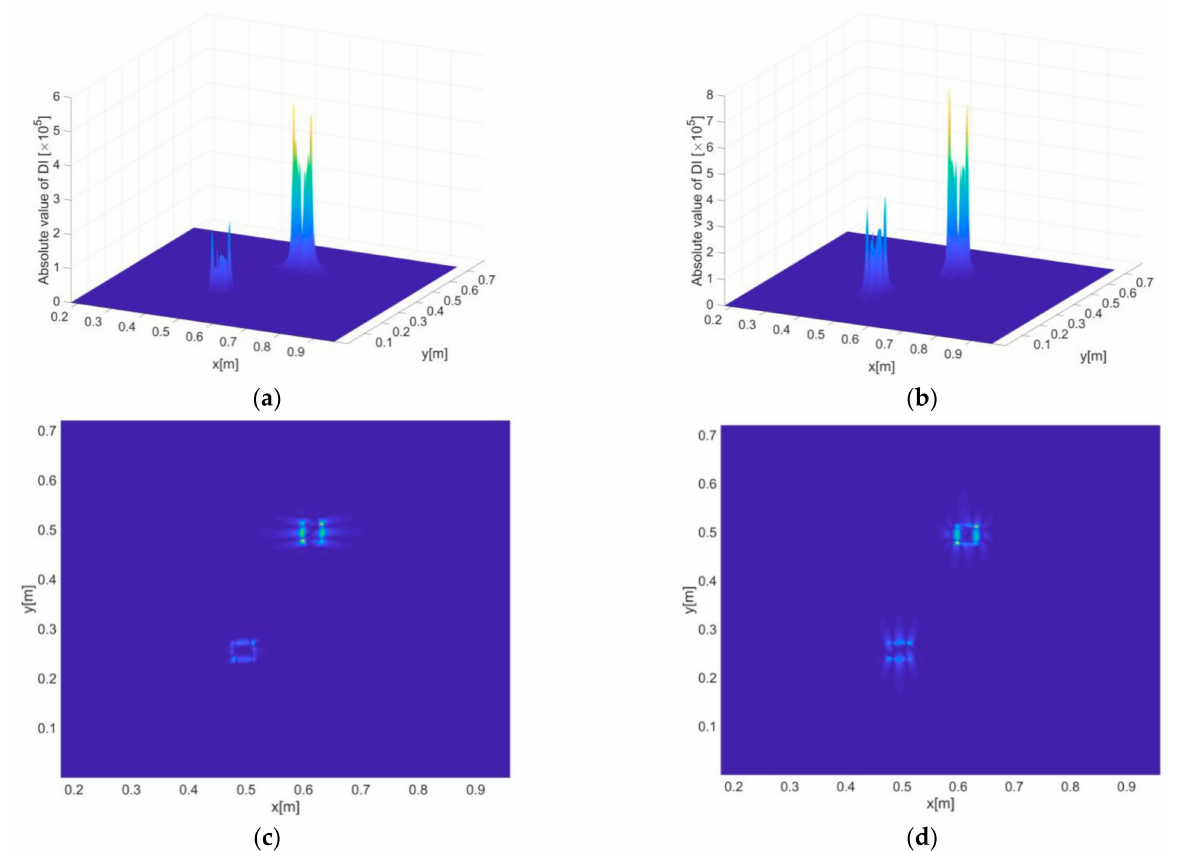
Figure 15. Delamination identification results of scenario C by using uni-axial strain measurement: ( a ) and ( c ) display the three- and two-dimensional views of detection results using strains in x direction, respectively, whereas ( b ) and ( d ) display the three- and two-dimensional views of detection results using strains in y direction,